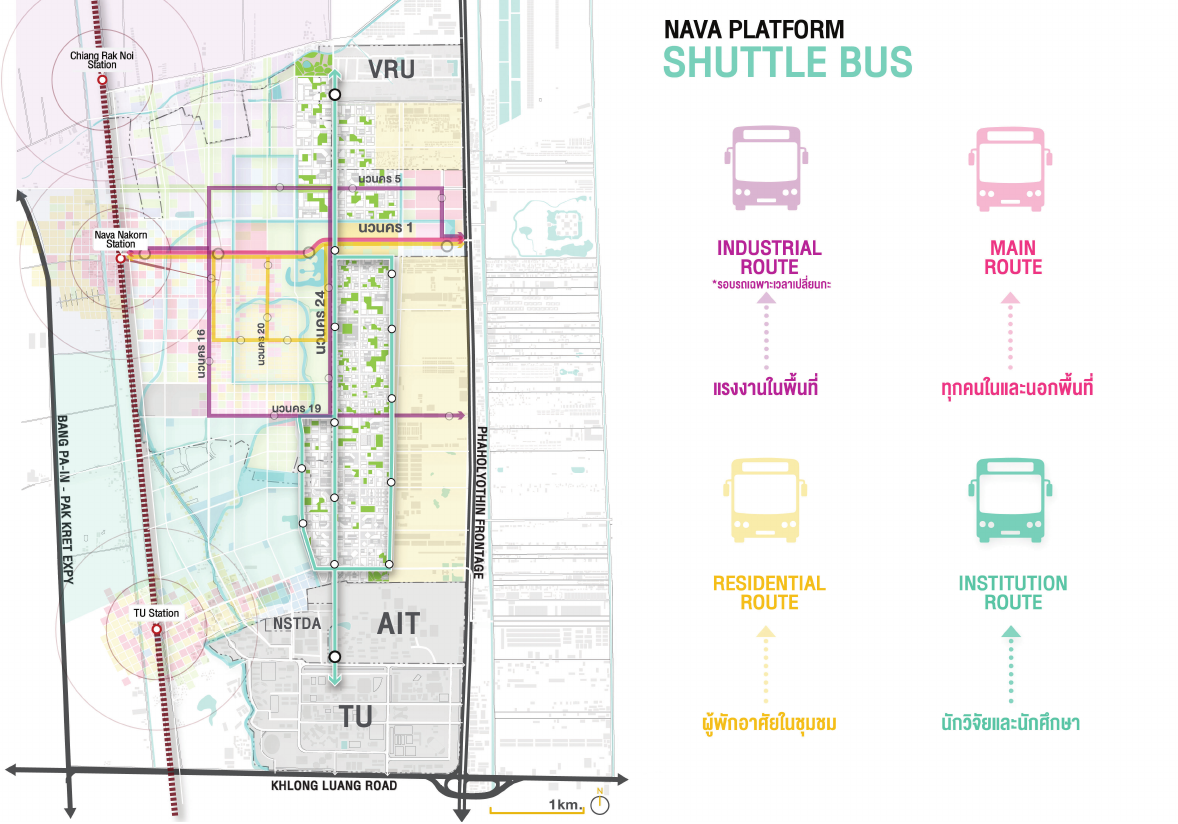
Figure 14. Vision for expanded public-transit/shuttle-bus routes to connect the Nava Nakorn community with the local university clusters to the north and south. Graphics credits to Apicha Prom- nao, Kotchakorn Chaiyatum, Phatharamon Panon, Thanakit Singduang, Thannicha Charoenwan, AR416